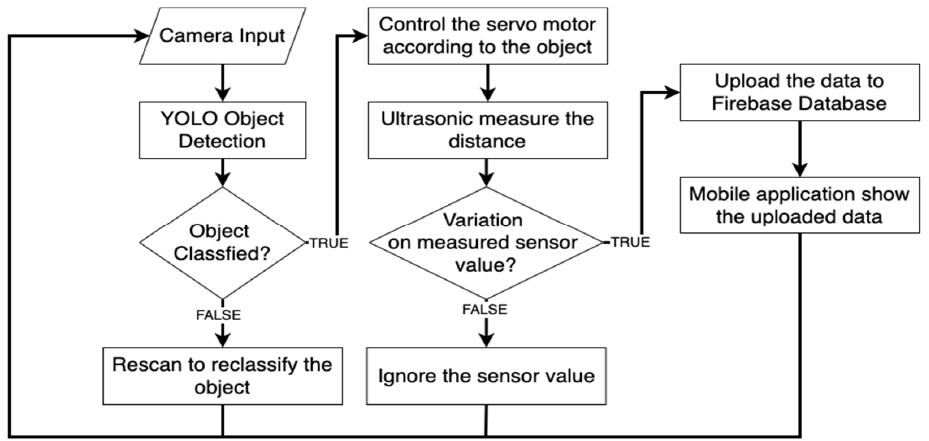
Figure 4. System flowchart.